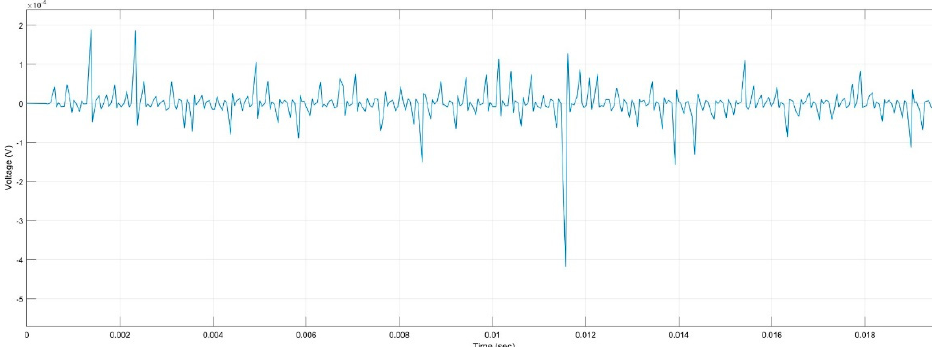
Figure 3. PD Activity for ER, 5 kV, h, r.